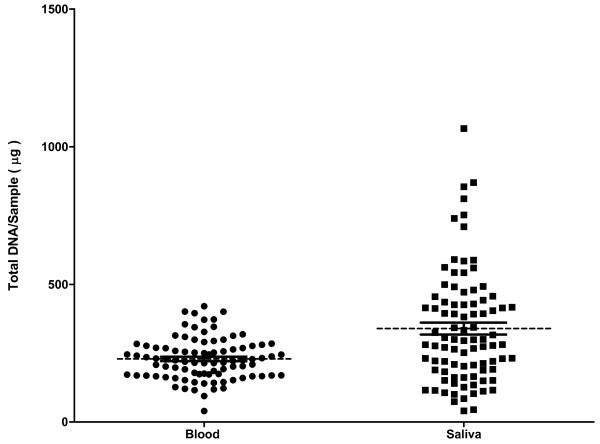
Scattergram of DNA yield (μg) in 89 blood and saliva samples. Scattergram of total DNA yield (μg) in 89 blood and saliva samples. The dashed line represents the mean value and continuous lines denote standard error of mean (SEM).